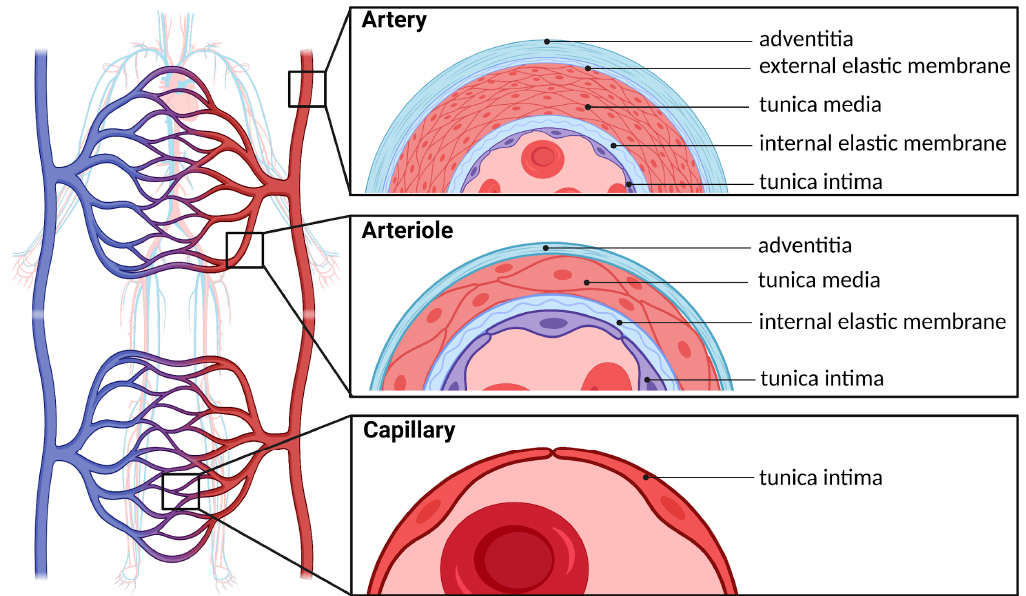
Figure 1. Structure of the arterial system. The circulatory system is a network of arteries and veins connected by capillaries where oxygen and nutrient exchange occurs. The inner lining of arteries, arterioles, and capillaries is known as the tunica intima, which is composed exclusively of endothelial cells. Arterioles and arteries additionally have a series of elastic and muscular